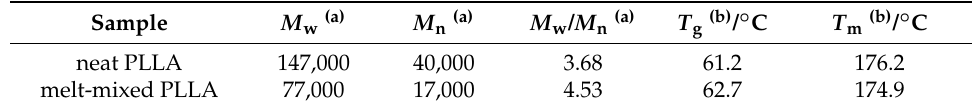
Table 1. Molecular weights and thermal transition data of neat poly( L -lactic acid) (PLLA) and